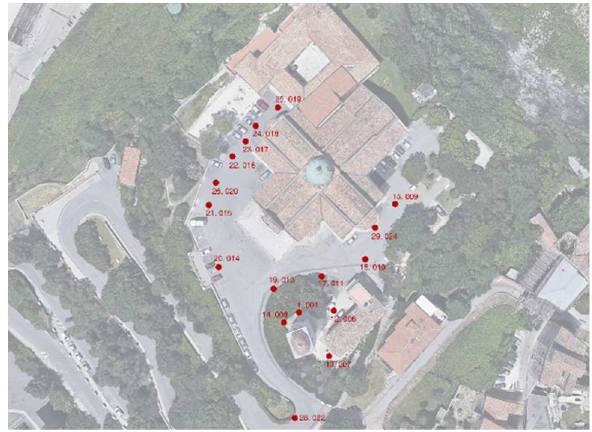
Figure 4 - External stations in the complex of San Ciriaco Then the complete cloud was cut to isolate the tower to use it as the basis of the structural model (Figure 5).